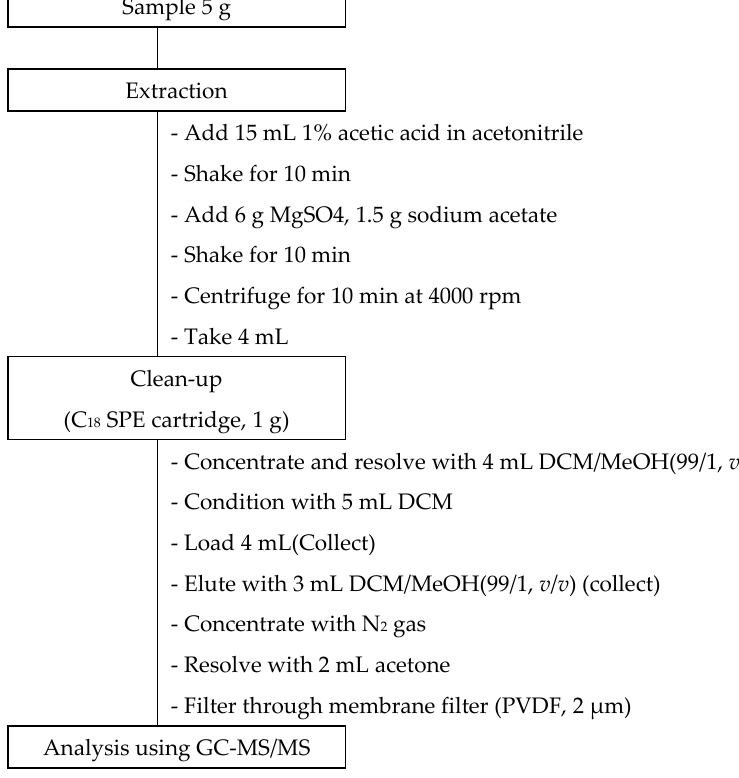
Figure A2. Flow chart of sample preparation for the multi-residue analysis method.